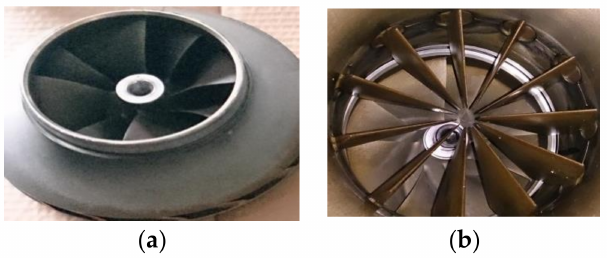
Figure 2. Compressor impeller and inlet guide vanes. ( a ). Impeller; ( b ). The IGV at the suction end of the